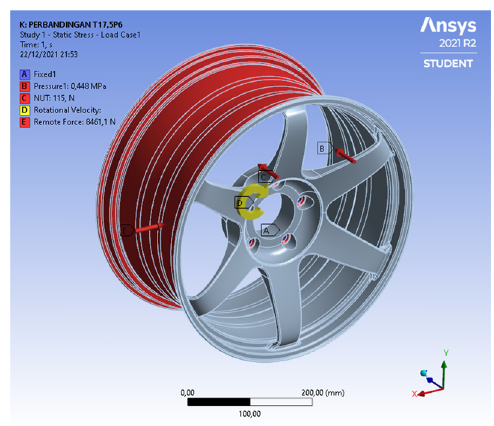
Figure 6: Static settings for ANSYS simulation.